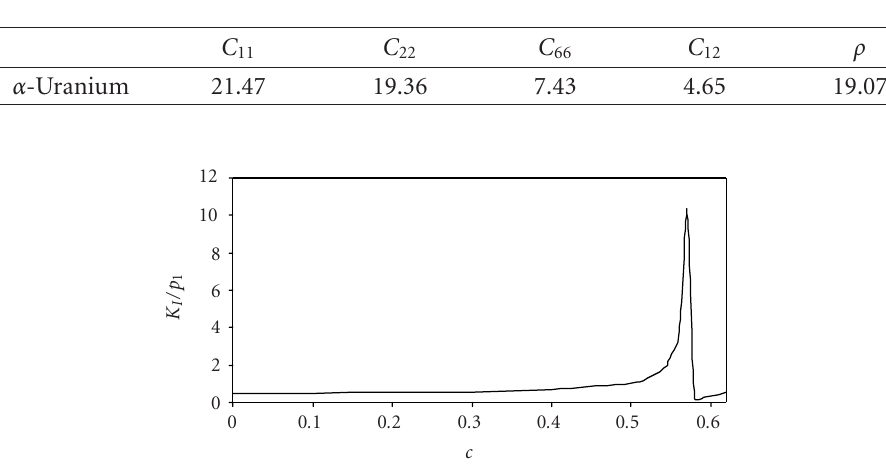
Figure 4.1 Plot of K I /p 1 versus c for h = 6, x 0 /a = 0 . 6, p 2 /p 1 = 1 .